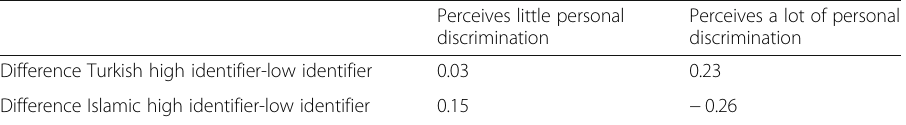
Table 5 Differences in the predicted probabilities between the highest identifiers and lowest identifiers, according to perceived personal